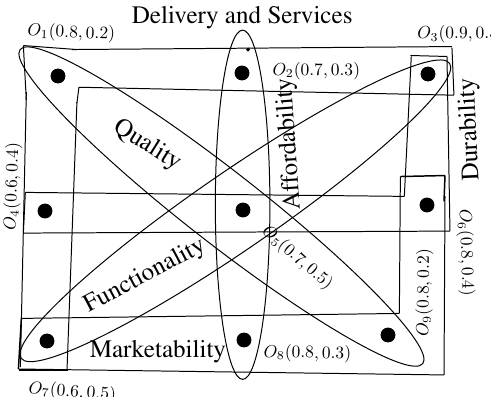
Figure 6. Six-rung orthopair fuzzy model to select the most appropriate